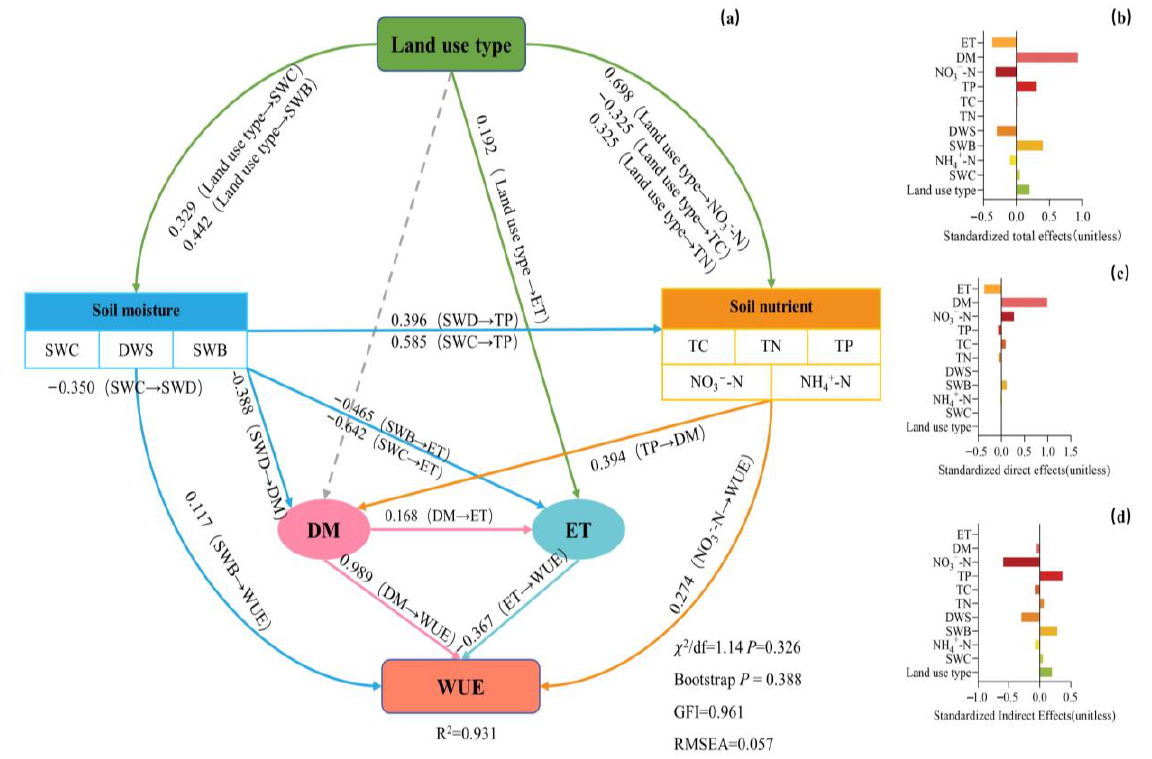
Figure 4. Structural Equation Model (SEM) describing the effect of land use types and environmental factors on water use efficiency. ( a ) Path analysis of influencing factors of water use efficiency, ( b ) standardized total effects of factors affecting water use efficiency. ( c ) Standardized direct effects of factors affecting water use efficiency. ( d ) Standardized indirect effects of factors affecting water use efficiency. Numbers adjacent to arrows are indicative of the effect size ( p < 0.05) of the relationship. Grey dotted line indicates no significant relationship. R 2 denotes the proportion of variance explained. Soil nutrients and soil moisture respectively contain several independent variables in the model, to simplify the graph, we group them in the same box in the model. TP: soil total phosphorus content; TC: soil total carbon content; TN: soil total nitrogen content; NH 4+ -N: soil ammonium ni-